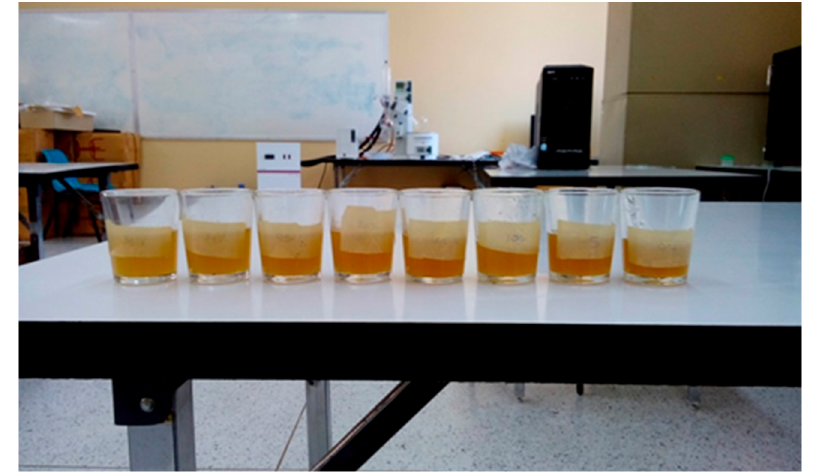
Figure 1. Honey samples with different water adulterations.